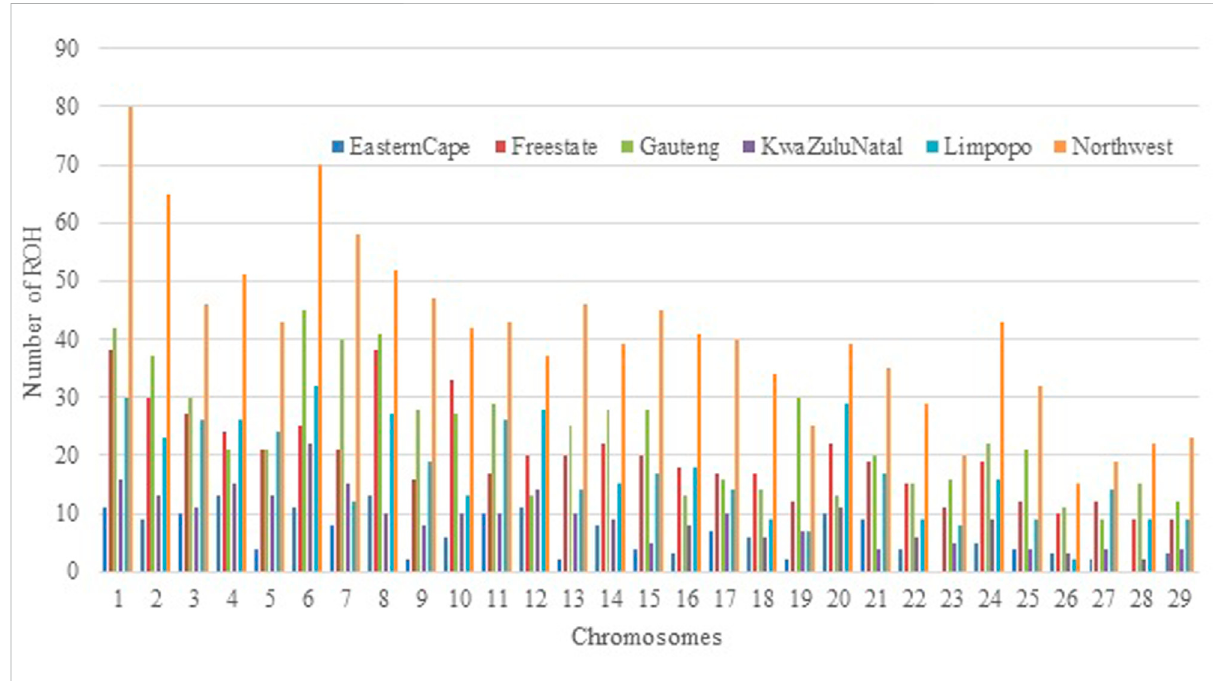
FIGURE 5 Number of runs of homozygosity (ROH) per chromosome identi fi ed across all